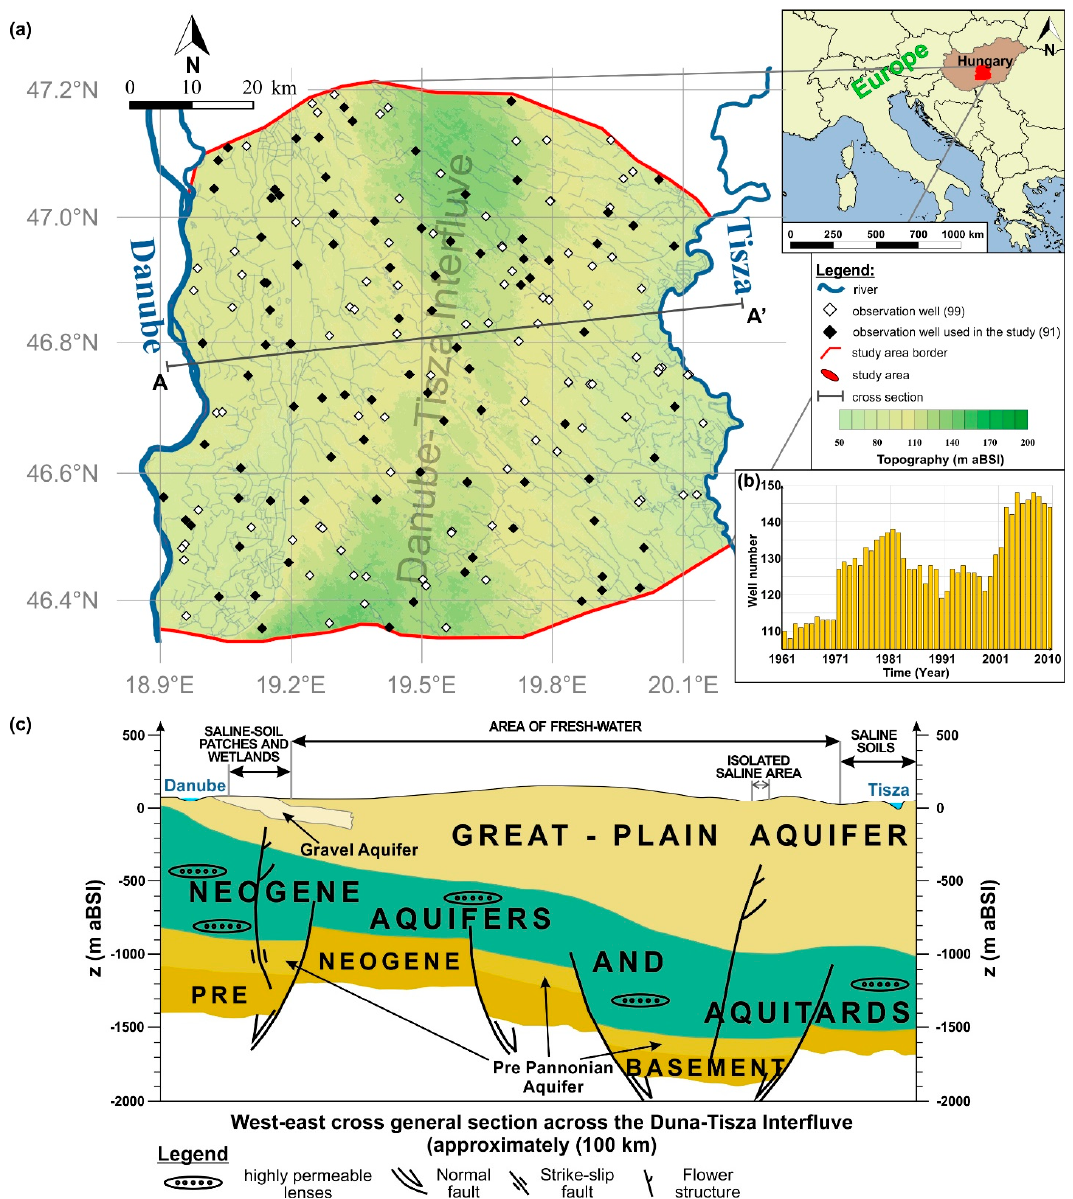
Figure 1. Spatial ( a ) and temporal ( b ) distribution of the SGW monitoring network of the study area. Black diamonds represent the SGW wells used in the current study, while those not used are shown in white. The digital elevation model (DEM) was constructed from SRTM data [45]. Hydrogeological type section of the Danube–Tisza Interfluve with the aquifer ( c ) based on Mádl-Sz ő nyi and Tóth, 2009 [37].